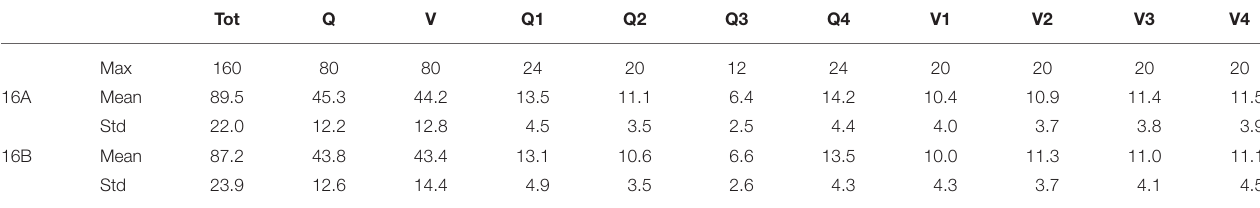
TABLE 1 | Descriptive statistics for test administration 16A ( N = 76,948) and 16 B ( N = 55,033), maximum possible score, mean, and standard deviation. Tot